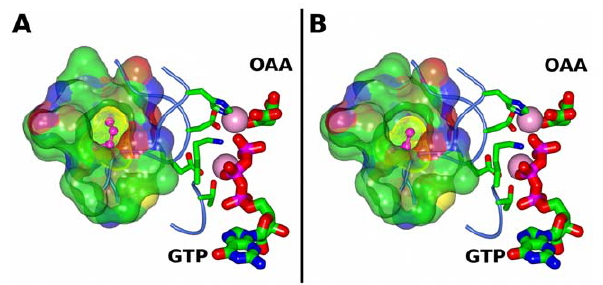
Figure 3. Structural models of cytosolic PEPCK. Based on previously published structural models of ( A ) rat cytosolic PEPCK (isoleucine 267) (PDBID 3DT7 [33]) and ( B ) human cytosolic PEPCK variant rs8192708 G (valine 267) (PDBID 1KHB [31]), the hydrophobic pocket to which the residue at position 267 belongs is rendered as a semi-transparent molecular surface colored by atom type (carbon, green; oxygen, red; nitrogen, blue; sulfur, yellow). The van der Waals surface for isoleucine ( A ) and valine ( B ) is rendered as a dotted yellow surface. The metal ions are rendered as pink spheres, the catalytic and metal binding residues are rendered as thin cylinders colored by atom type and the substrates oxaloacetate (OAA) and guanosine triphos- phate (GTP) are rendered as thick sticks, colored by atom type and labeled.